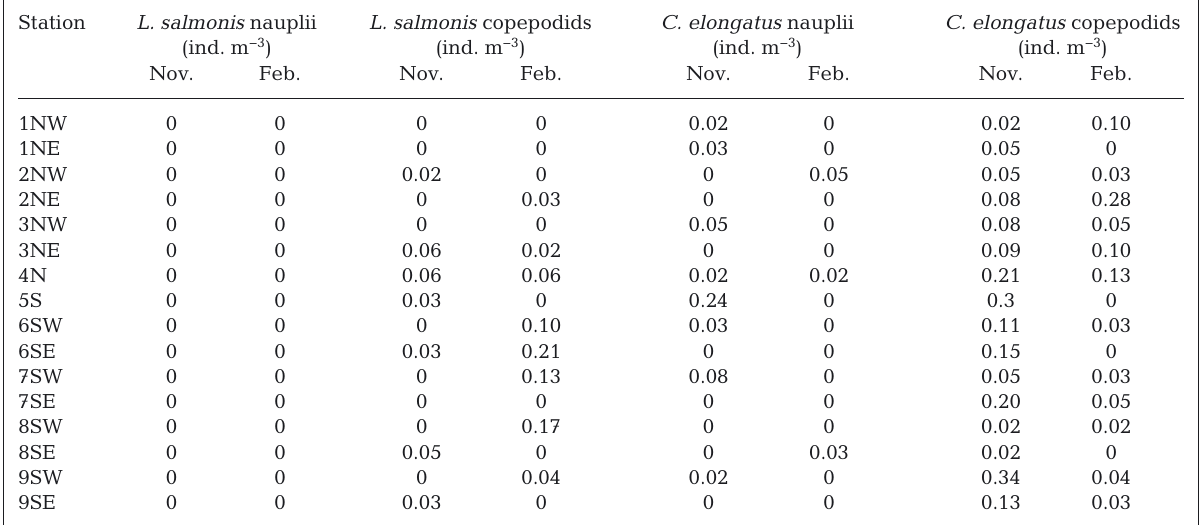
and in the eastern and western shores,